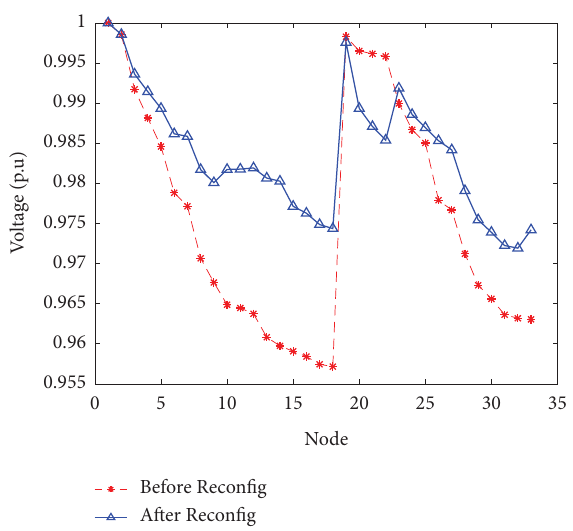
Figure 4: Voltage profle of a 33-bus system for light load.